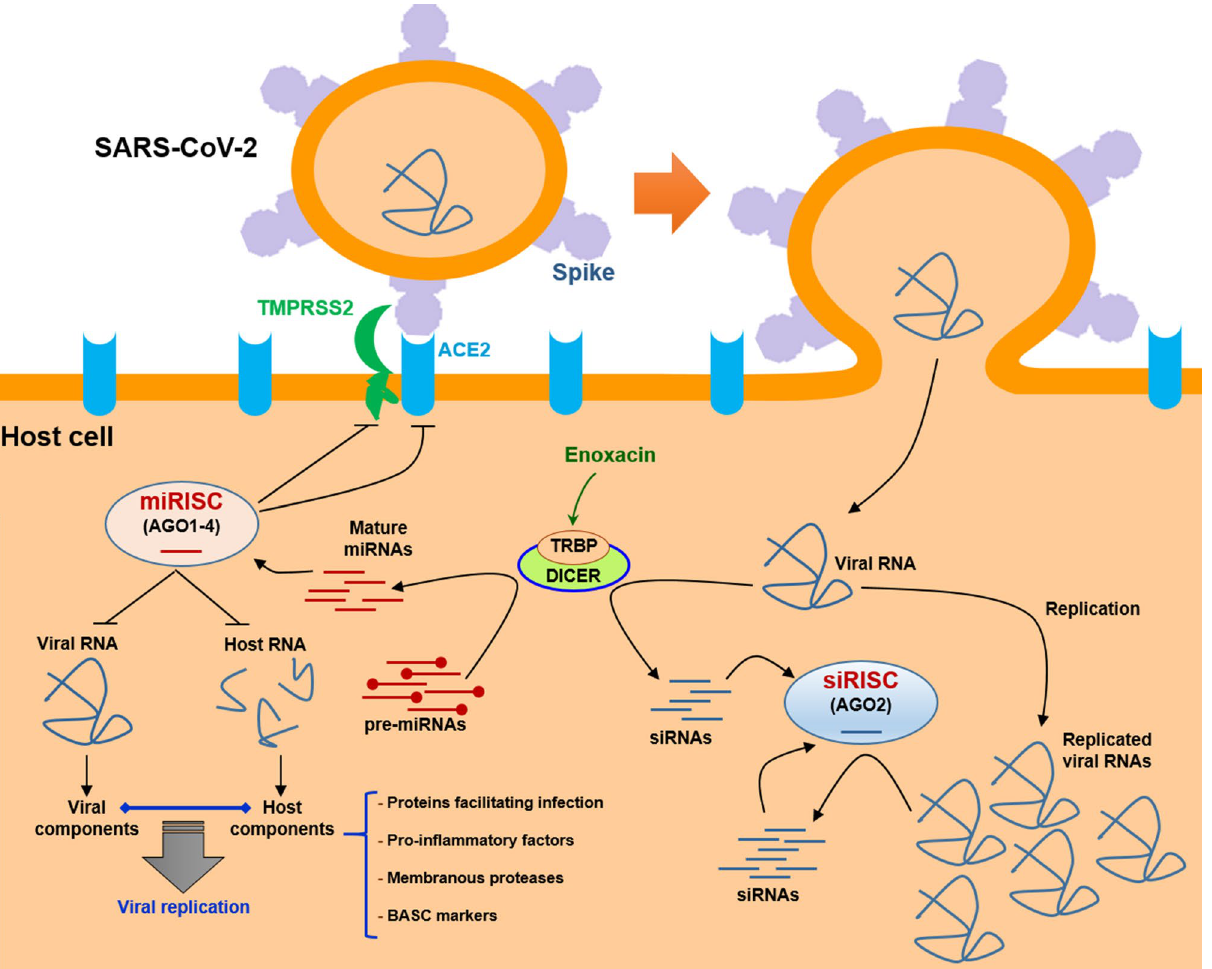
Figure 5. Modeling of the potential SARS-CoV-2 inhibition by enoxacin. Enoxacin enhances the RNAi pathway through binding to TRBP, the physical partner of DICER. This interaction enhances the dicing of viral RNA genome directly by DICER as well as upregulates certain mature miRNAs which could target SARS-CoV-2 RNA genome and viral transcripts including VSRs through RISC complexes. Enoxacin-induced miRNAs might also target entry receptors and membranous proteases in host cells, pro-inflammatory genes in the immune cells, and stem cell markers in BASCs. It might also suppress the interactions between certain viral and host RNA molecules which mediate and facilitate viral replication and infection. ( ) designates mutual interaction. miRISC: miRNA-induced silencing complex; siRISC: siRNA-induced silencing